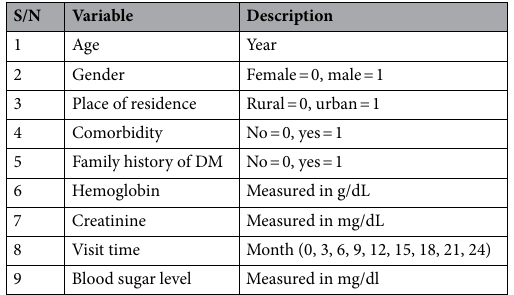
Table 1. The mode, scale and nature of the variables in this